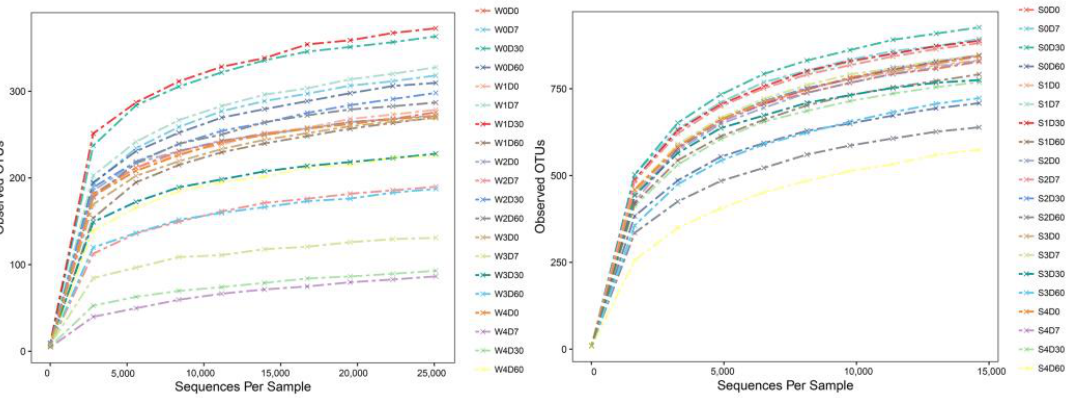
Figure 3. Effects of different concentrations of florfenicol on dilution curve of operational taxonomic units (OTUs) of bacteria in an aquatic microcosm model. W, water; S, sediments.